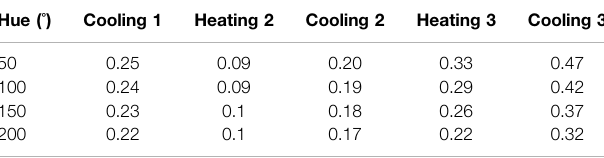
TABLE 3 | LC2 patch: Temperature shift ( ° C) compared to the fi rst heating calibration curve. Hue ( ° )